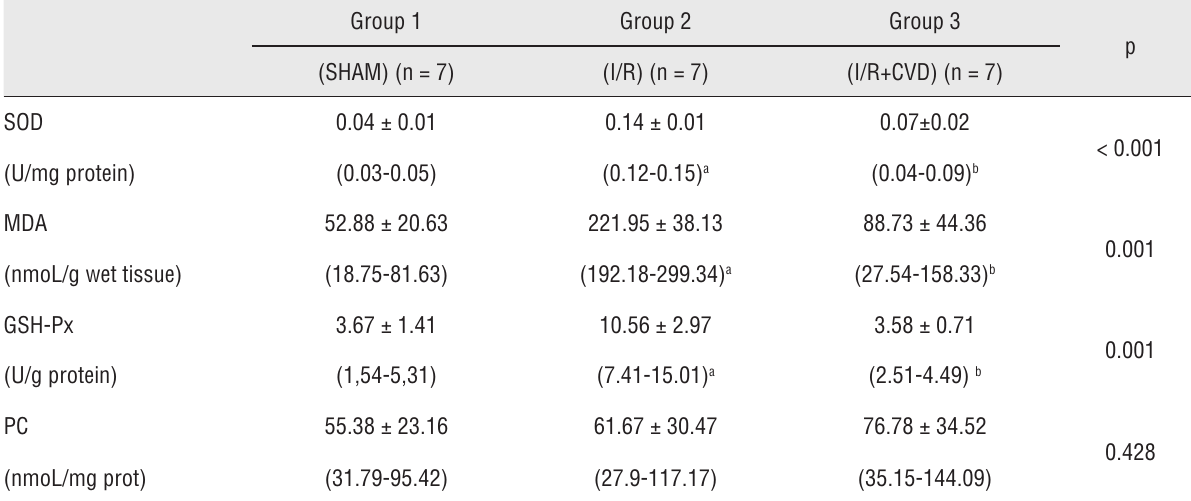
Table 3 - The antioxidant enzyme activities and levels of MDA and PC in testicular tissues of all groups and statistical